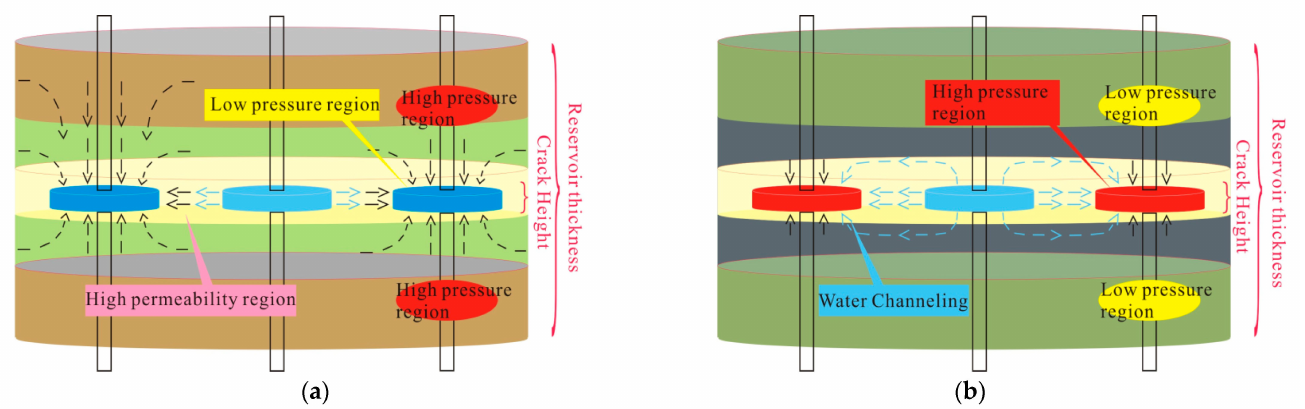
Figure 2. Profile of horizontal fracture water injection development in early stage by natural energy